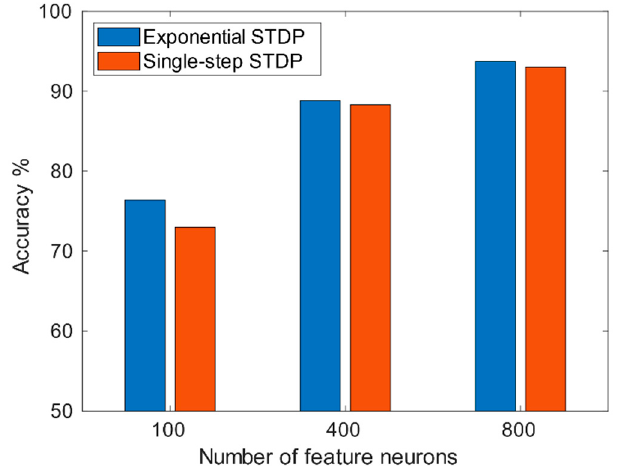
Figure 10. Impact of learning rules on accuracy.